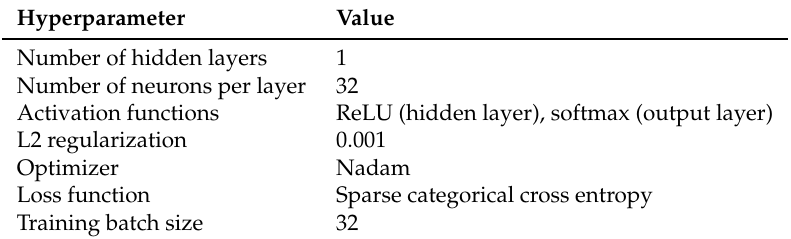
Figure 11. Progressions of pit stop probability predictions in an exemplary race as outputted by the final trained hybrid NN. The plot shows the reactions to safety car phases and possible undercut attempts. The horizontal line at a 50% probability level separates the no pit stop from the pit stop region. Table 14. Hyperparameters of the neural network for the tire compound decision.